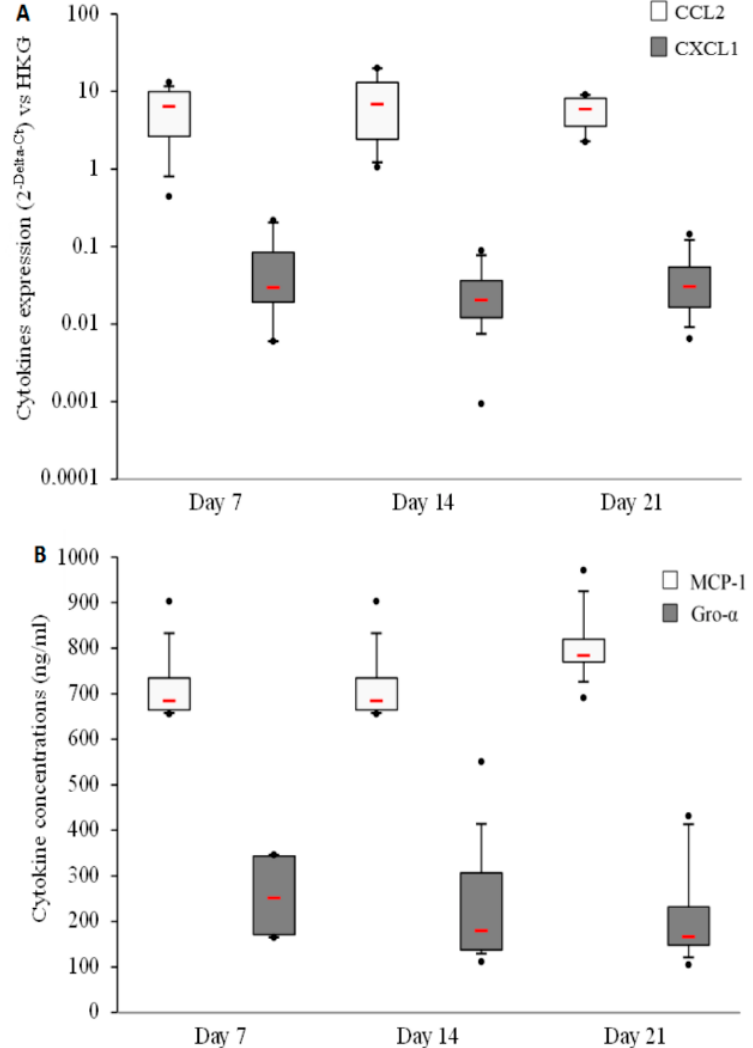
Figure 1. Gro- α and MCP-1 are produced by human primary bone cells in basal culture conditions. ( A ) Human primary bone cells’ cytokine expressions were measured using Real-Time Polymerase Chain Reaction (RT-PCR) after 7, 14, and 21 days of culture. The HPRT1 gene was used as the housekeeping gene (HKG); ( B ) Cytokine concentrations were measured in human primary bone cell culture supernatants after 7, 14, and 21 days. Both experiments were performed on 8 independent donors in duplicate. Red bars represent median values. Black points represent maximum and minimum values. Black bars represent first and ninth deciles and the limits of rectangles represent first and third quartiles.